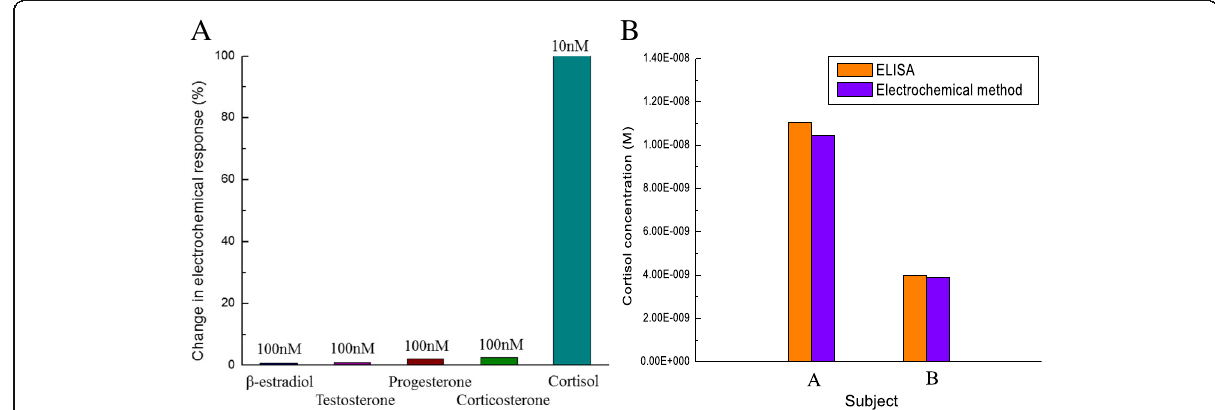
Fig. 5 a Interference study involving β -estradiol (100 nM), testosterone (100 nM), progesterone (100 nM), and corticosterone (100 nM) with respect to cortisol (1 0nM). b Comparison of salivary cortisol measurements using ELISA and electrochemical